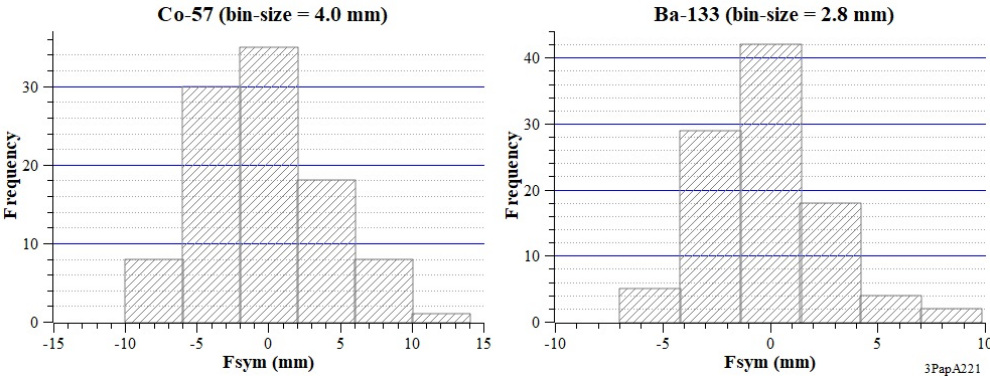
Figure A12. Histograms of average Fsym crystal-pixel values from Co-57 ( left ) and Ba-133 ( right ) data-takings. The plots were drawn with 4.0- and 2.8-mm bins, respectively.